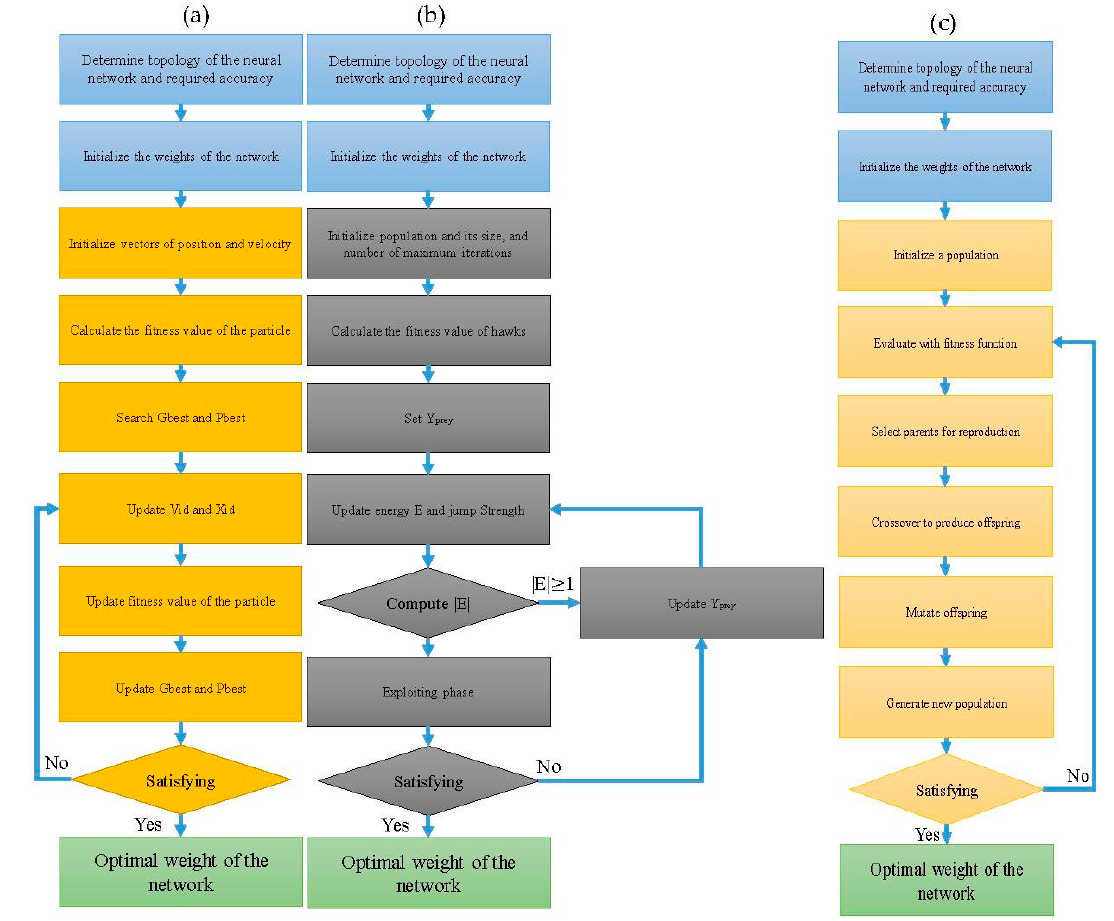
Figure 3. Flow chart of the hybrid algorithm of ( a ) ANN-PSO (ANN with particle swarm optimization), ( b ) ANN-HHO (ANN with Harris hawks optimization), and ( c ) ANN-GA (ANN with genetic algorithm).